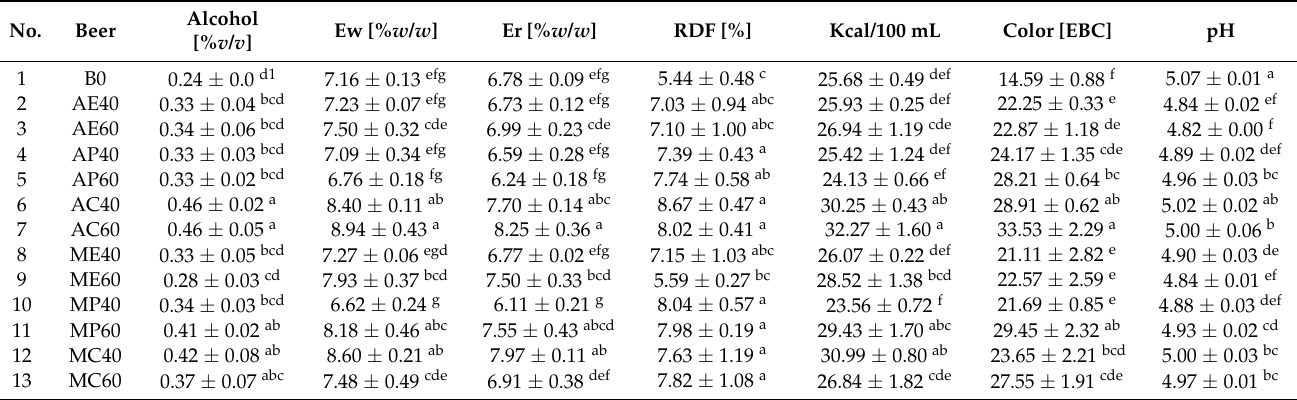
Table 1. Basic physicochemical